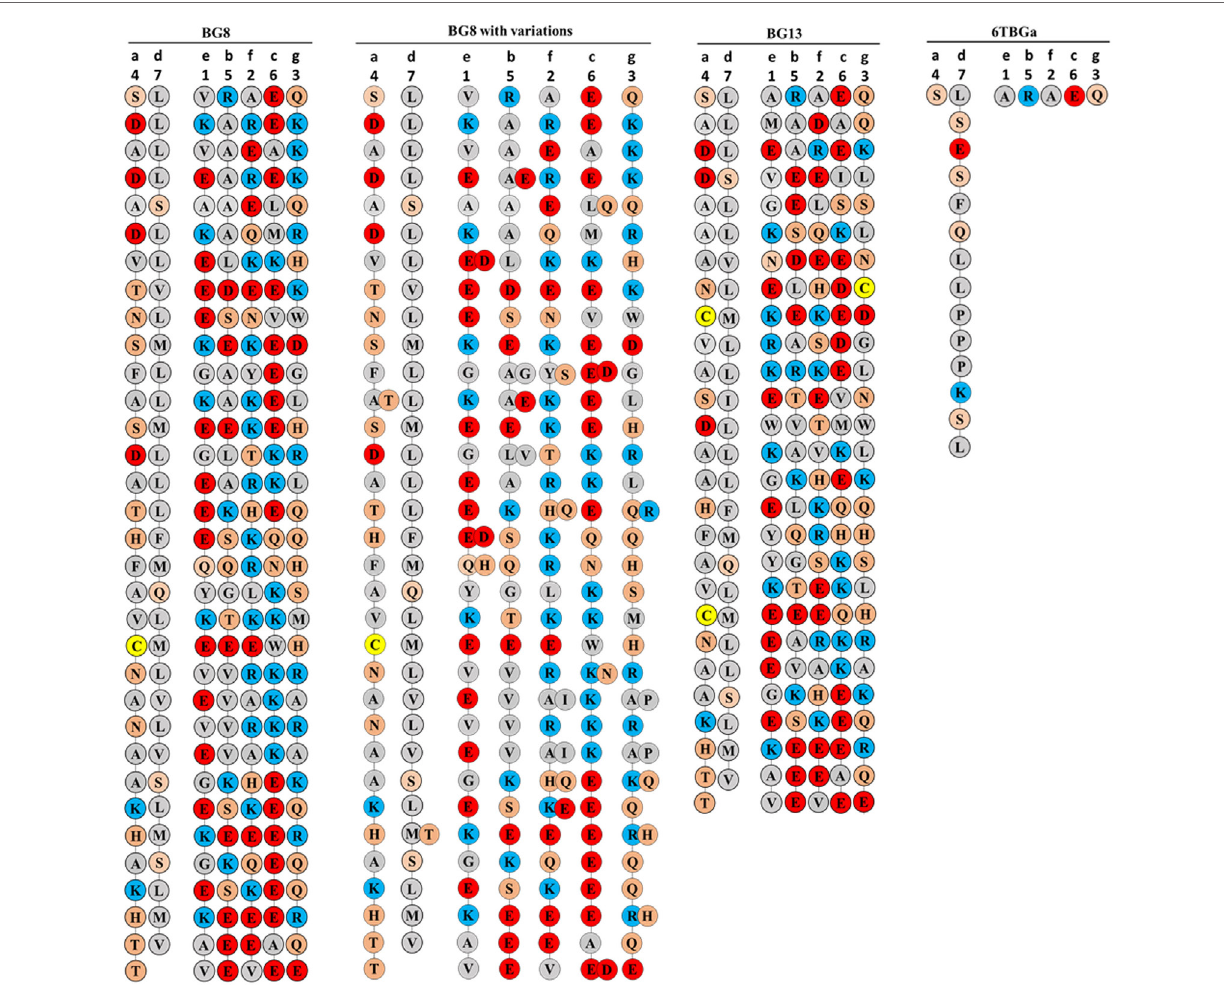
FigUre 8 | Coiled-coil representations of the cytoplasmic tails of BG8; BG8 with the different amino acids found in BG9 and BG12 of the B12 haplotype and in the “(nearly) full-length conceptual transcripts” (i.e., exons without introns) of the dominant sequences of line 15I (B15), line P2a (B19), line N (B21); B13 which is identical to the “(nearly) full-length conceptual transcript” (i.e., exons without introns) of the dominant sequence of line 6 1 (B2); and the dominant sequence of line 6 1 (B2) with the expected amino acid sequence from the most frequent clone using the real transcript (i.e., exons with the intron read-throughs leading to an early stop codon, sequence 6TBGa-1). The transmembrane region would be at the top of the page, so the C-terminus of the BG protein is at the bottom of the page. The positions of the seven codons in the 21 nucleotide repeat are indicated with numbers at the top, and the position of the seven amino acid positions of the “true heptad repeat” are indicated with letters. Colors of circles surrounding the amino acids (single letter code) indicate features of the amino acids (red, acidic; blue, basic; orange, polar; and gray, hydrophobic except for yellow, cysteine), with the understanding that these features do not correspond to full descriptions of the properties of the amino